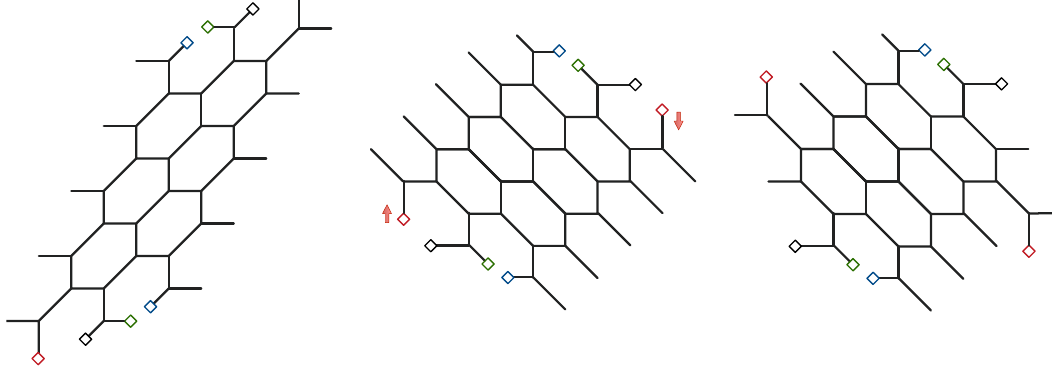
Figure 13 . STS-transformation of the 5d quiver gauge theory [6]